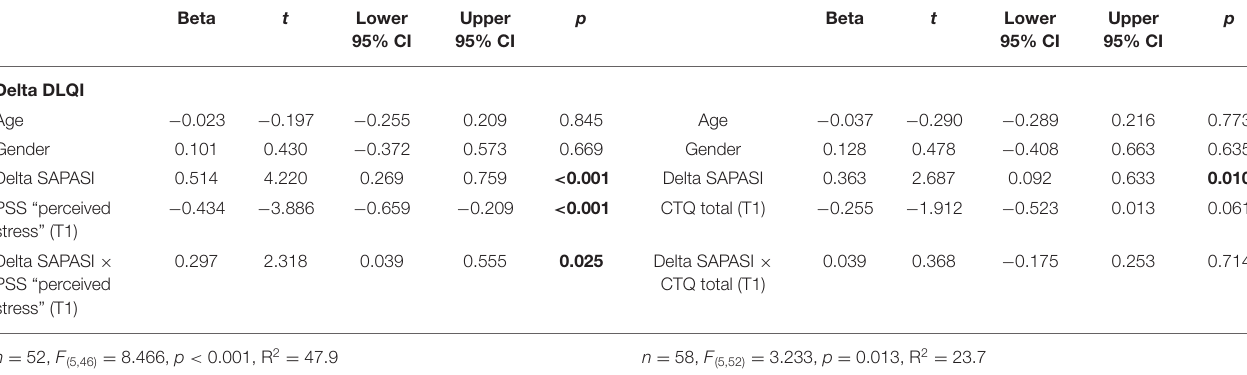
TABLE 4 | Results of the moderator analysis according to the Macro Modell Process by